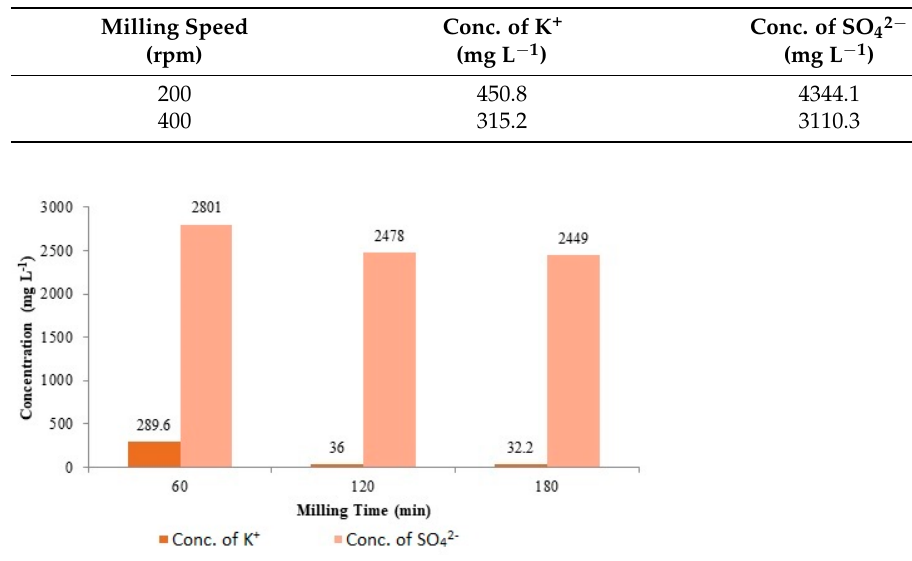
Figure 7. Profile of the nutrients release characteristics of milled kaolinite-K 2 SO 4 mixtures for 120 min with different milling times, after being dispersed in distilled water for 24 h.